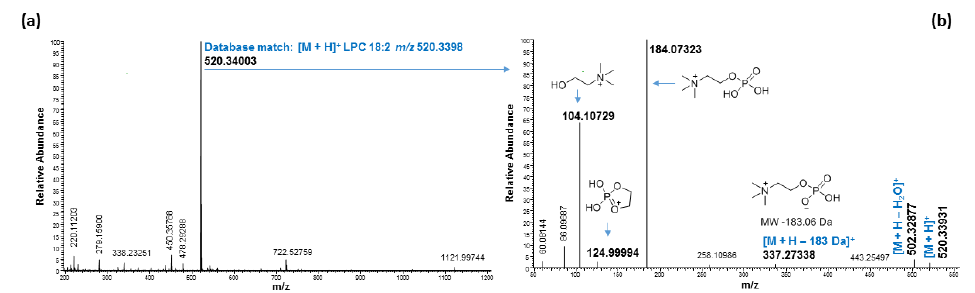
Figure 8. Mass spectrum of LPC eluted at 4.00 min with molecular ion at m / z 520.34003 in positive mode ( a ) fragmentation of LPC with molecular ion at m / z 520.34003 ( b ). Five LPEs were also identified in the SPE phospholipid fraction and were eluted between 3.53 and 4.82 min (Figure 2). Mass spectra and fragment ions of LPE 18:2 observed in both positive and negative mode are shown in Figure 9. The diagnostic